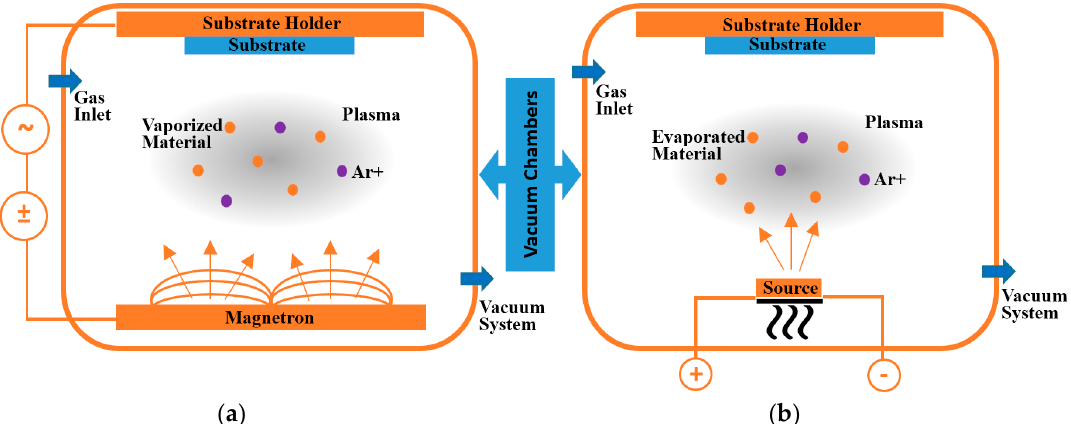
Figure 2. Schematic drawing of two conventional PVD processes: ( a ) sputtering and ( b ) evaporating using ionized Argon (Ar+) gas.